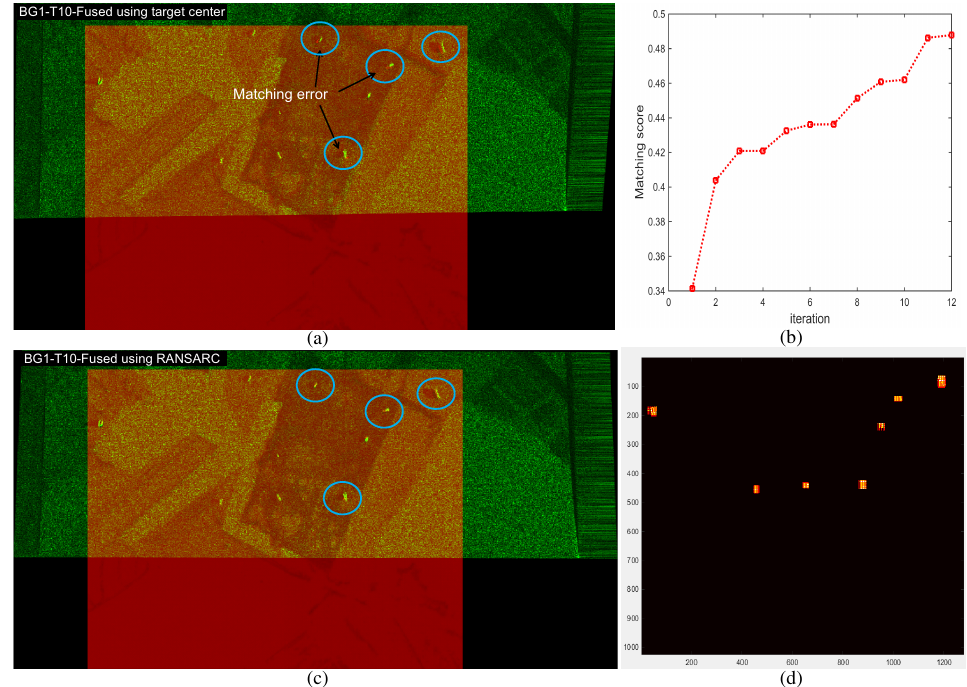
Figure 24. SAR and IR registration results for the background ID1 using BG1-T10-IR/SAR images: ( a ) initial automatic registration using a brute-force search from the detected target centers; ( b ) registration optimization curve of the proposed RANSARC; ( c ) refined registration results; ( d ) detected region overlap by the estimated homography.